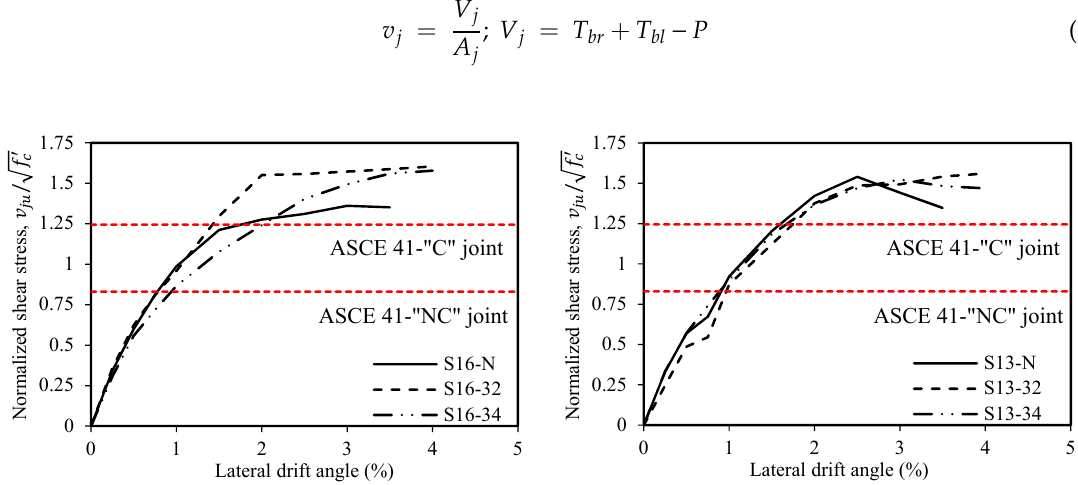
Figure 11. Relationship between the normalized joint shear stress and the lateral drift angle.